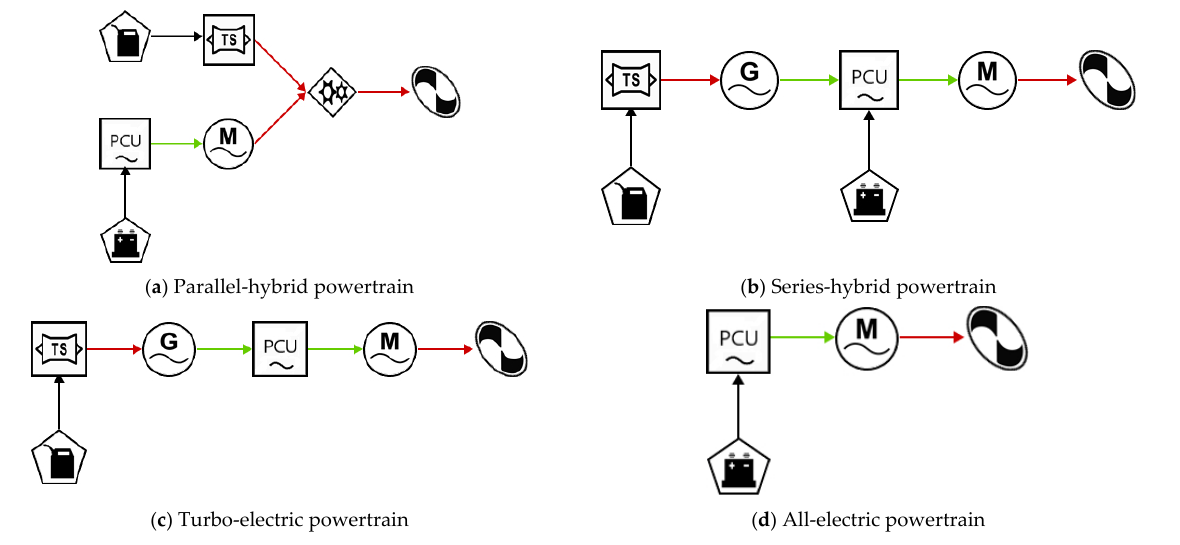
Figure 2. Adapted AIAA symbols. (From [21] and reprinted by permission of the American Institute of Aeronautics and Astronautics, Inc.).